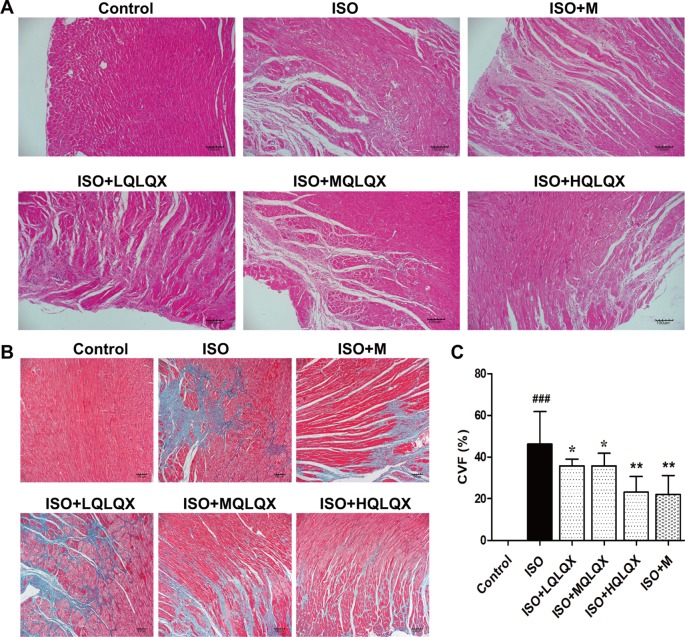
QLQX improves myocardial tissue structure and reduces cardiac fibrosis in the rats of CHF. (A) Representative HE staining images of left ventricles (×100) for the different groups treated by ISO with or without QLQX. (B) Representative images of Masson staining (×100) for the different groups treated by ISO with or without QLQX. (C) Quantitative analysis of collagen volume of left ventricle. Data are expressed as mean ± SD, n = 3. ###
p < 0.001 versus control group; *p < 0.05, **
p < 0.01 versus ISO group. ISO, isoproterenol.